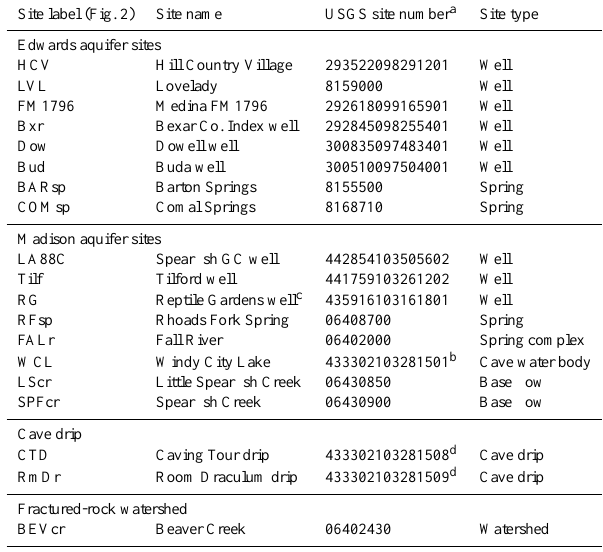
Table 3. Sites simulated. Site label (Fig. 2) Site